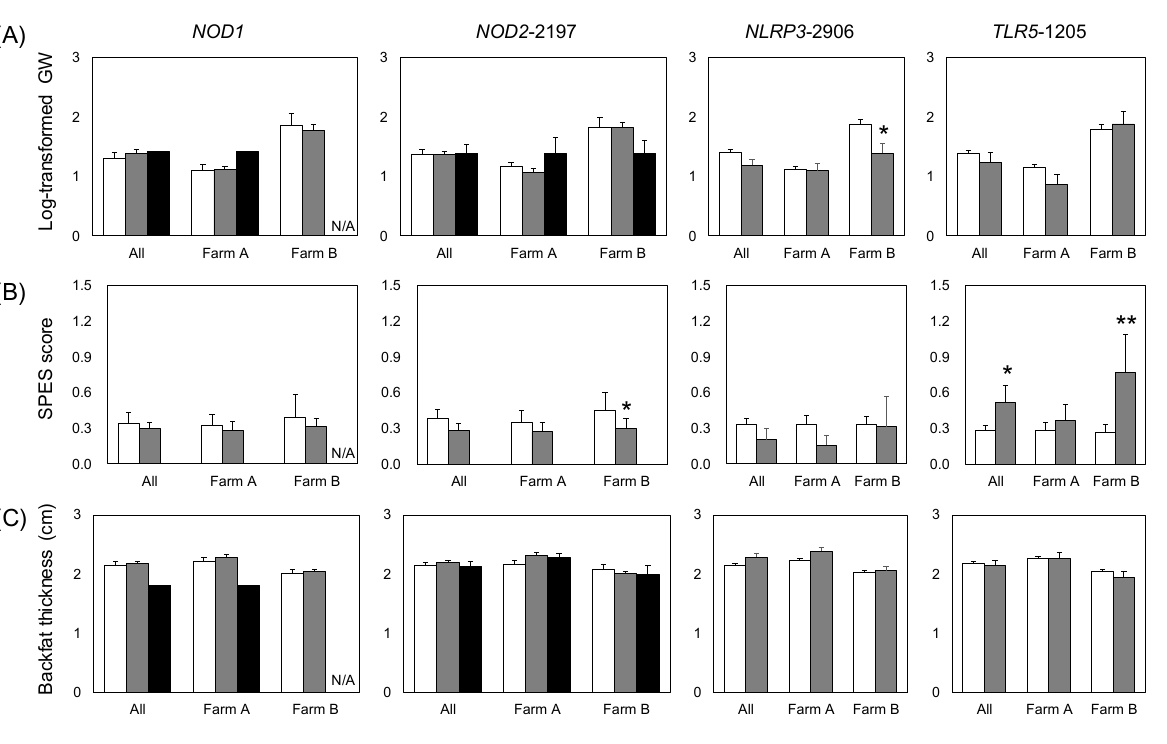
Figure 1. Trait values by PRR genotype for all of the pigs studied. ( A ) log-transformed Goodwin lung lesion score; ( B ) pleuritis (SPES score); ( C ) backfat thickness adjusted by carcass weight; ( D ) intramuscu- lar fat ratio; and antibody titers of ( E ) Mhp and ( F ) App. Error bars: standard error. Significant dif- ferences in the estimates (Tables 5, S2, and S3) are indicated by asterisks (** p < 0.01, * p < 0.05). N/A, not applicable, because no NOD1 +/+ individuals were observed on farm B. A pp S / P r a t i o M hp S / P r a t i o